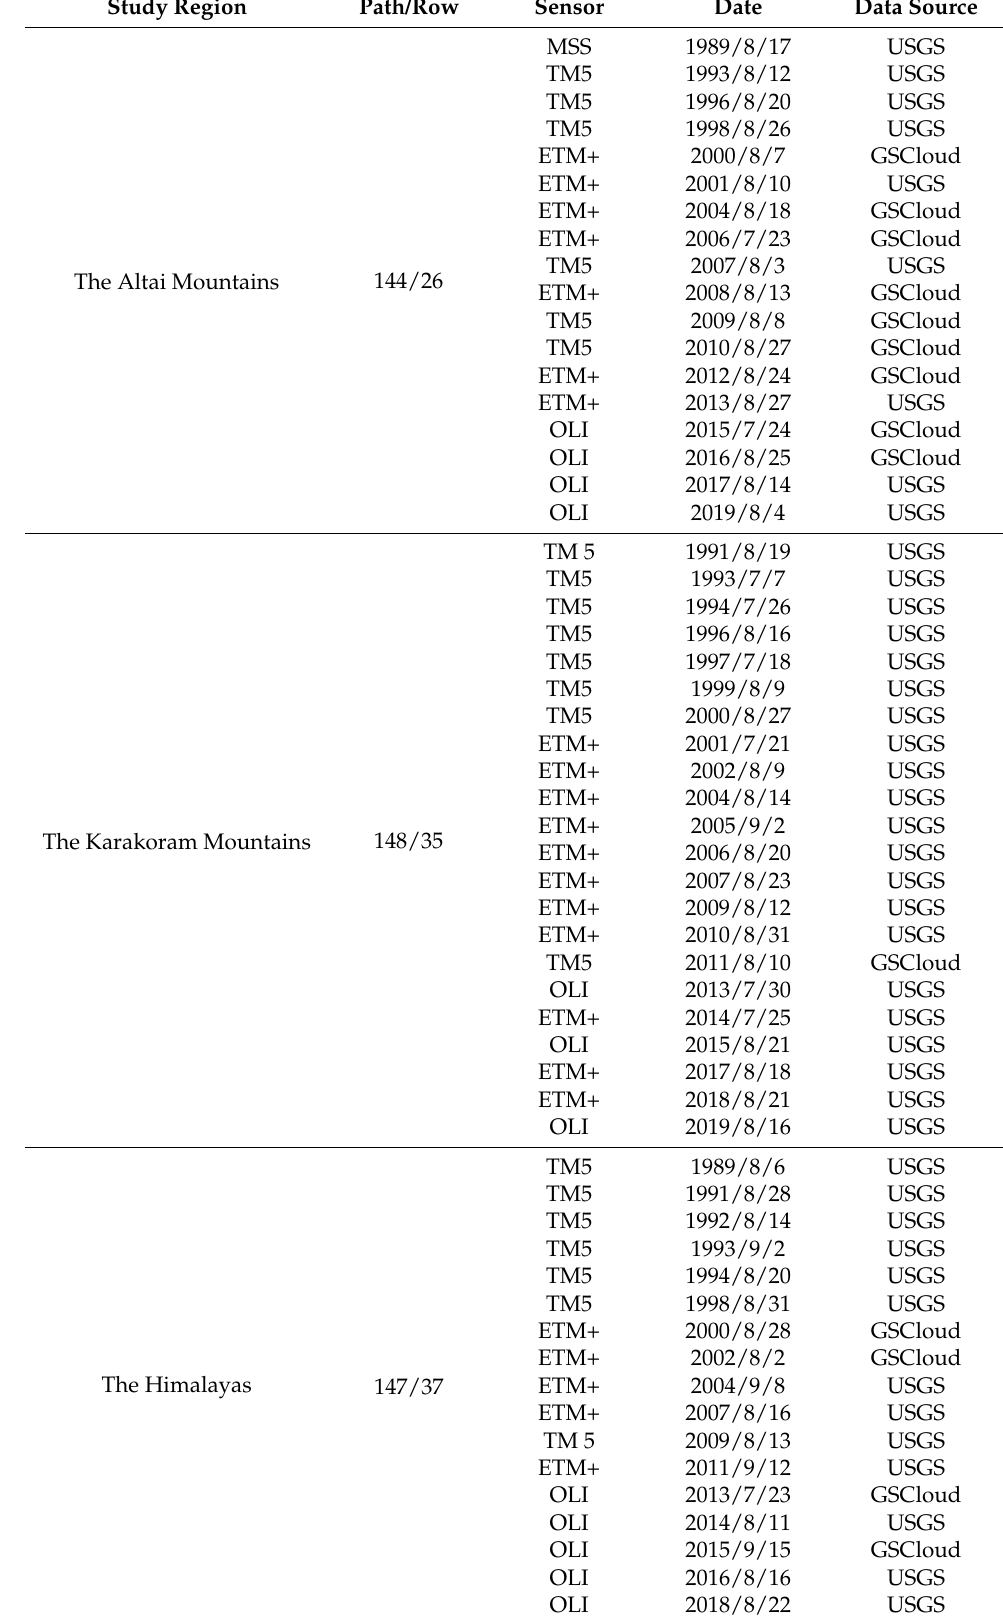
Table 1. Landsat MSS/TM/ETM+/OLI data used for mapping